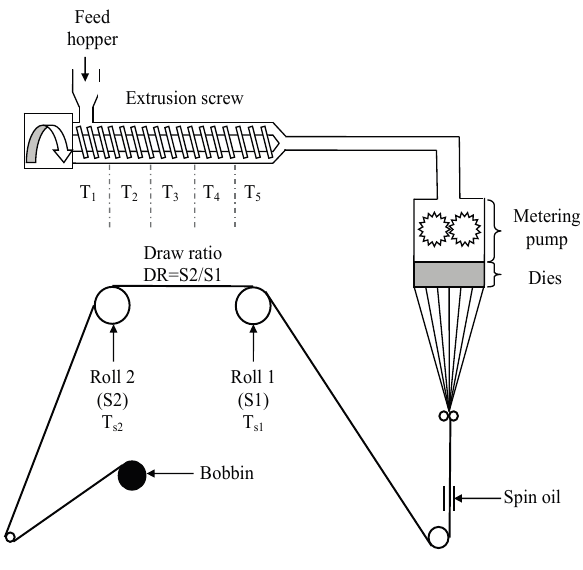
Figure 1. Principle of the melt-spinning